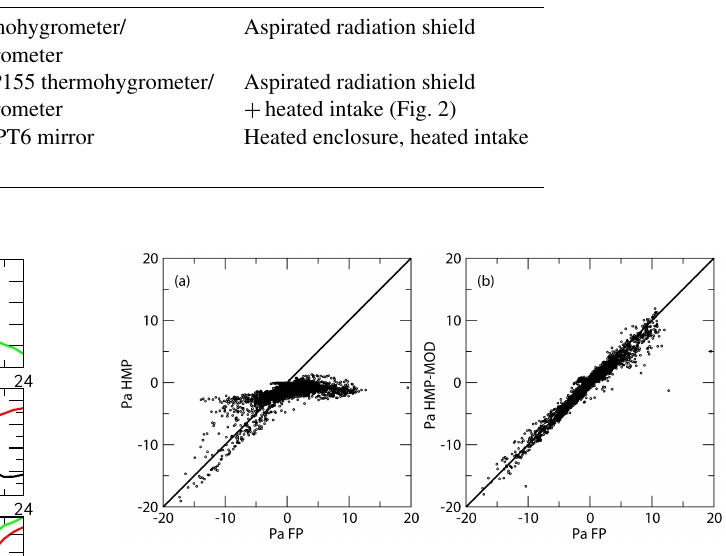
Figure 5. Regression of anomaly to saturation vapor pressure from HMP (a) and HMPmod (b) instruments against